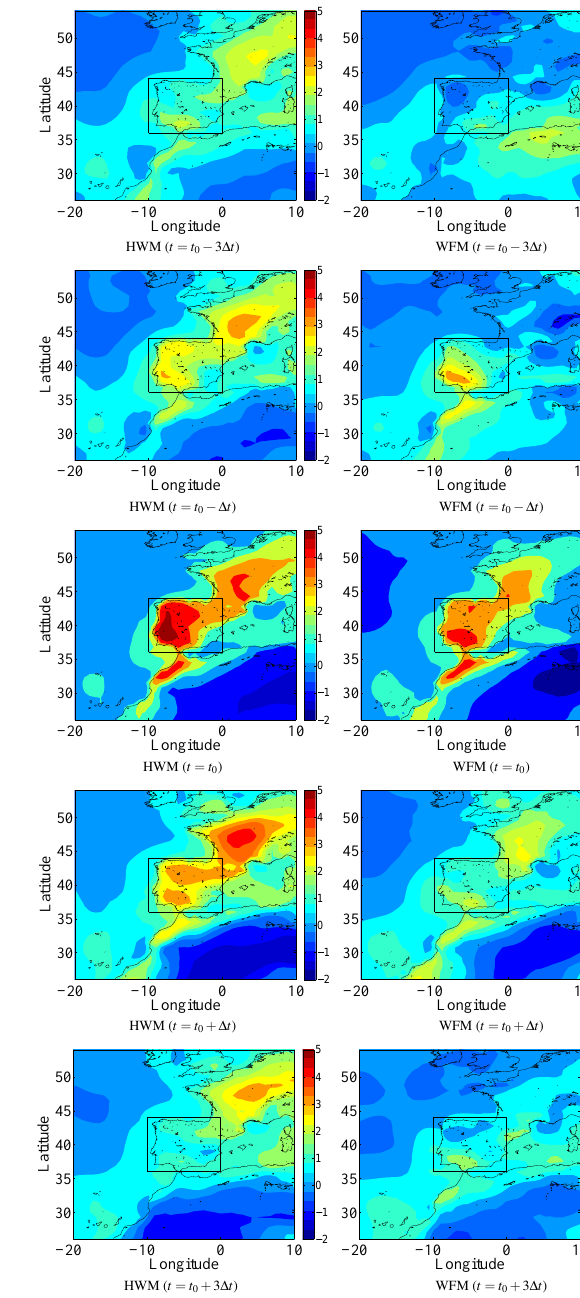
Figure 7. Same as Fig. 6 for the 2-m air temperature anomaly ( (cid:49)T 2